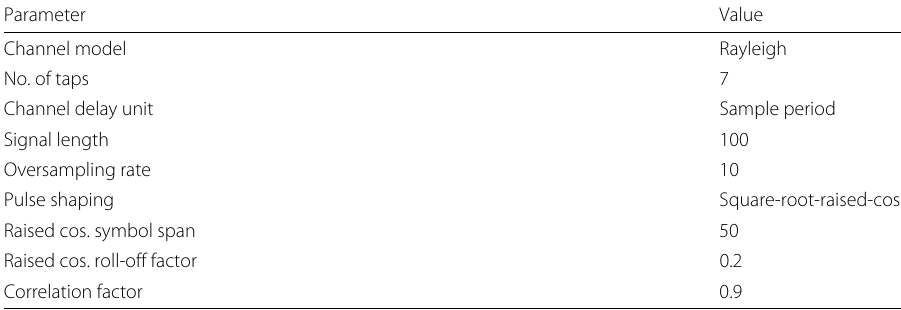
Table 1 Synthetic received signal simulation parameters